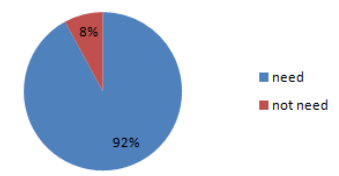
Figure 2: Tourists demand for mobile navigation system